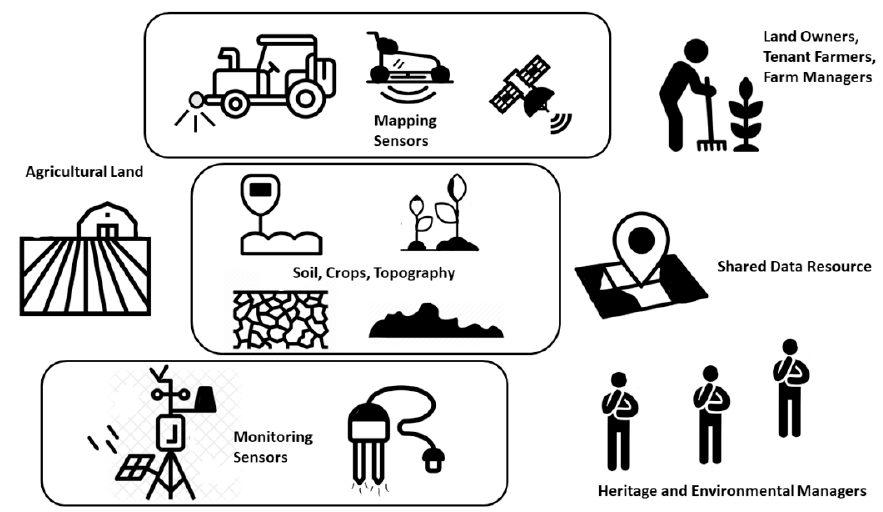
Figure 1. This schematic representation of sensors (top and bottom), targets of mapping and moni- toring projects (centre), data, and stakeholders who employ these technologies (right) provides an overview of the key socio-technical components of an integrated approach to sensing for sustainable agricultural land management.